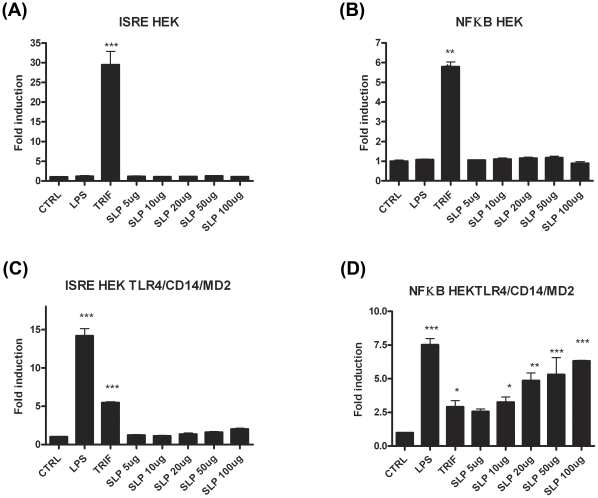
SLPs activate NFκB downstream of TLR4 but not IRF3.HEK293T cells and HEK293-MD2-CD14-TLR4 cells were transiently transfected with ISRE-luciferase (75 ng) and Renilla-luciferase (30 ng). 24 h after transfection, the cells were stimulated with LPS (100 ng/mL) or SLP (5–100 µg/mL) for 6 h. The cells were lysed, and luciferase activity as an indicator of ISRE activity (A&C) or NFκB activity (B&D) was subsequently measured. Results were normalised for Renilla-luciferase activity and represented as fold stimulation over the non-stimulated control. Results are expressed as mean (± SEM) for duplicate determinations and are representative of two separate experiments. *** p<0.001, determined by one-way ANOVA test.